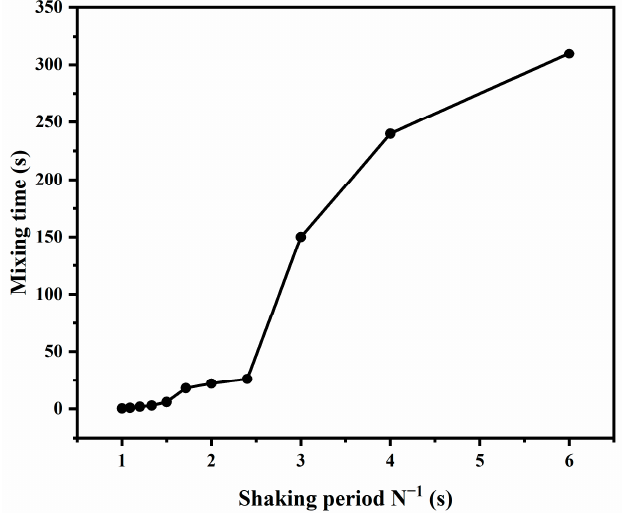
Figure 2. Relationship between mixing time and shaking